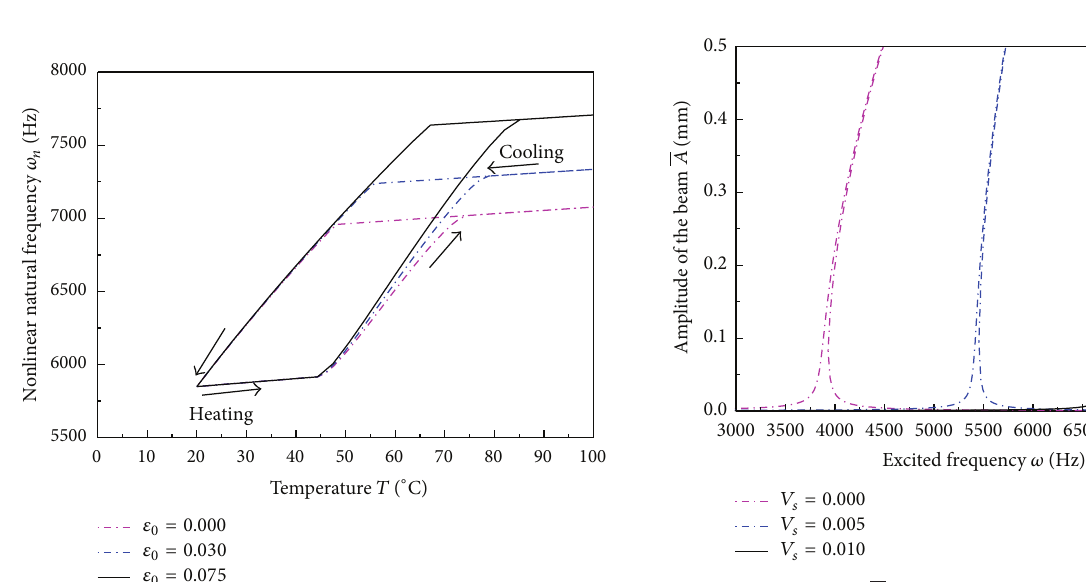
Figure 13: Variation of the nonlinear natural frequency with the actuation temperature for different 𝐴 0 ( 𝜀 0 = 0.03 , 𝑉 𝑠 = 0.005 , and 𝐿/ℎ = 10 ).